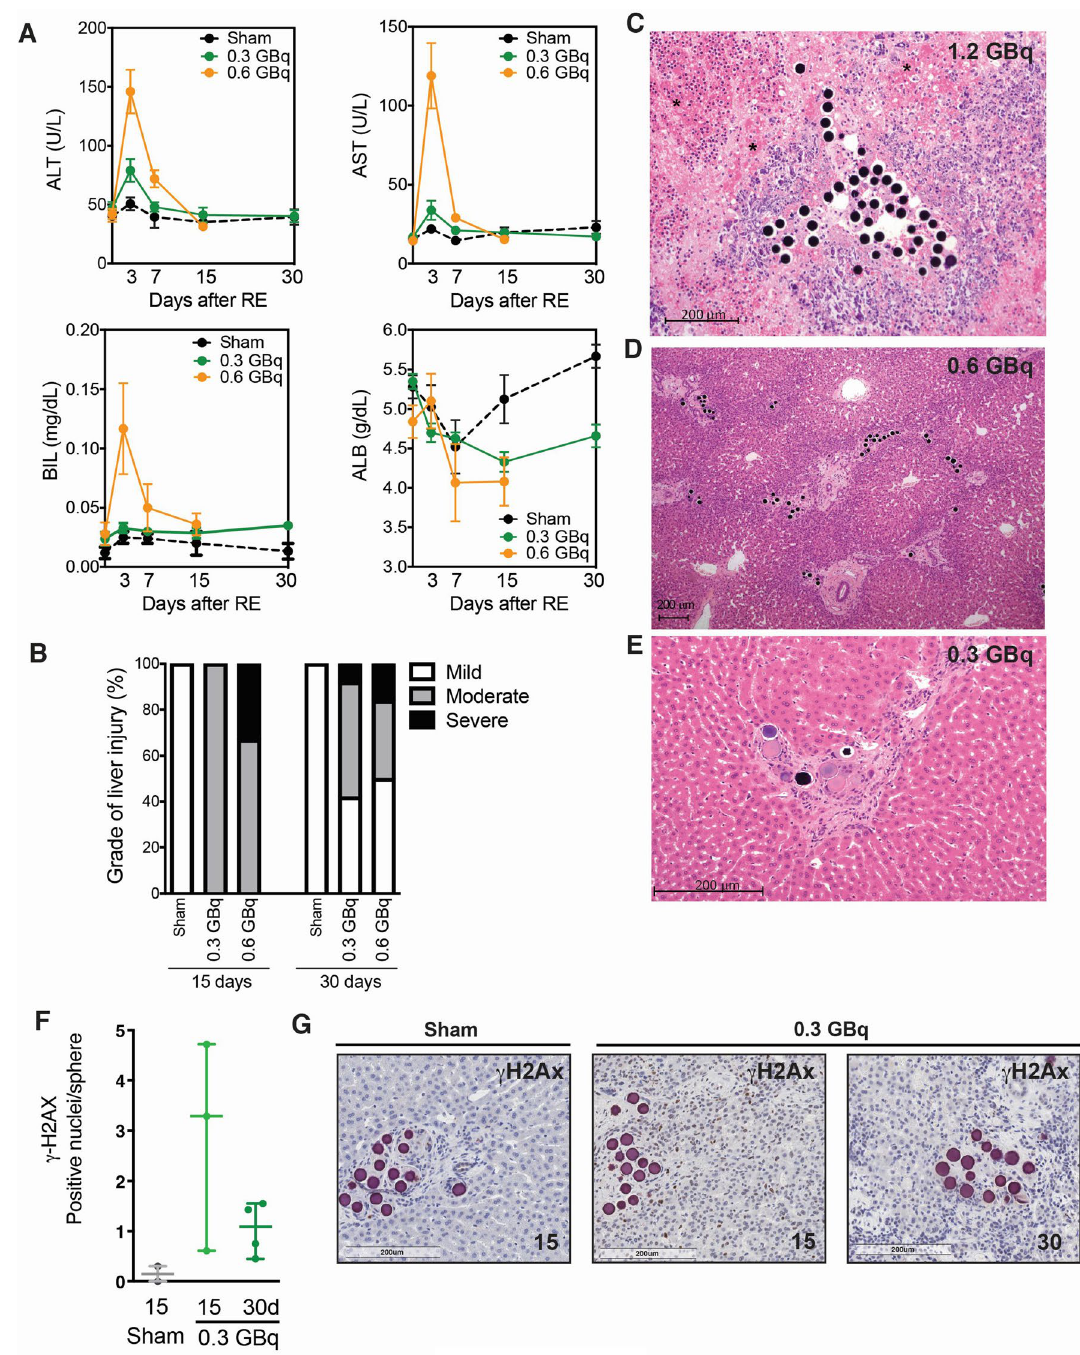
Figure 5. SIRT induced liver damage. ( A ) Serum liver transaminases and liver function in rabbits after CrLs SIRT. ( B ) Severity of liver damage in CrLs distribution among groups and along the time. ( C ) Severe liver damage: massive tissue necrosis (*) and periportal hepatocyte atrophy. Dense deposit of extravascular microspheres in the portal tract. (H&E, × 200). ( D ) Moderate liver damage: periportal necrosis, portal fibrosis with porto-portal fibrotic bridges, lobulillar atrophy, light ductular proliferation and dense extravascular particle concentration in portal tracts (H&E × 100). ( E ) Mild liver damage: foreign body giant cell reaction, frequent binucleate hepatocytes and slight portal lymphocytic infiltrate with preserved liver architecture. (H&E, × 200). ( F ) Quantification of DNA damage expressed as number of Gamma-H2AX-positive nuclei and ( G ) representative Gamma-H2AX stainings in CrLs in 0.3 GBq in comparison with sham group at 15 and 30